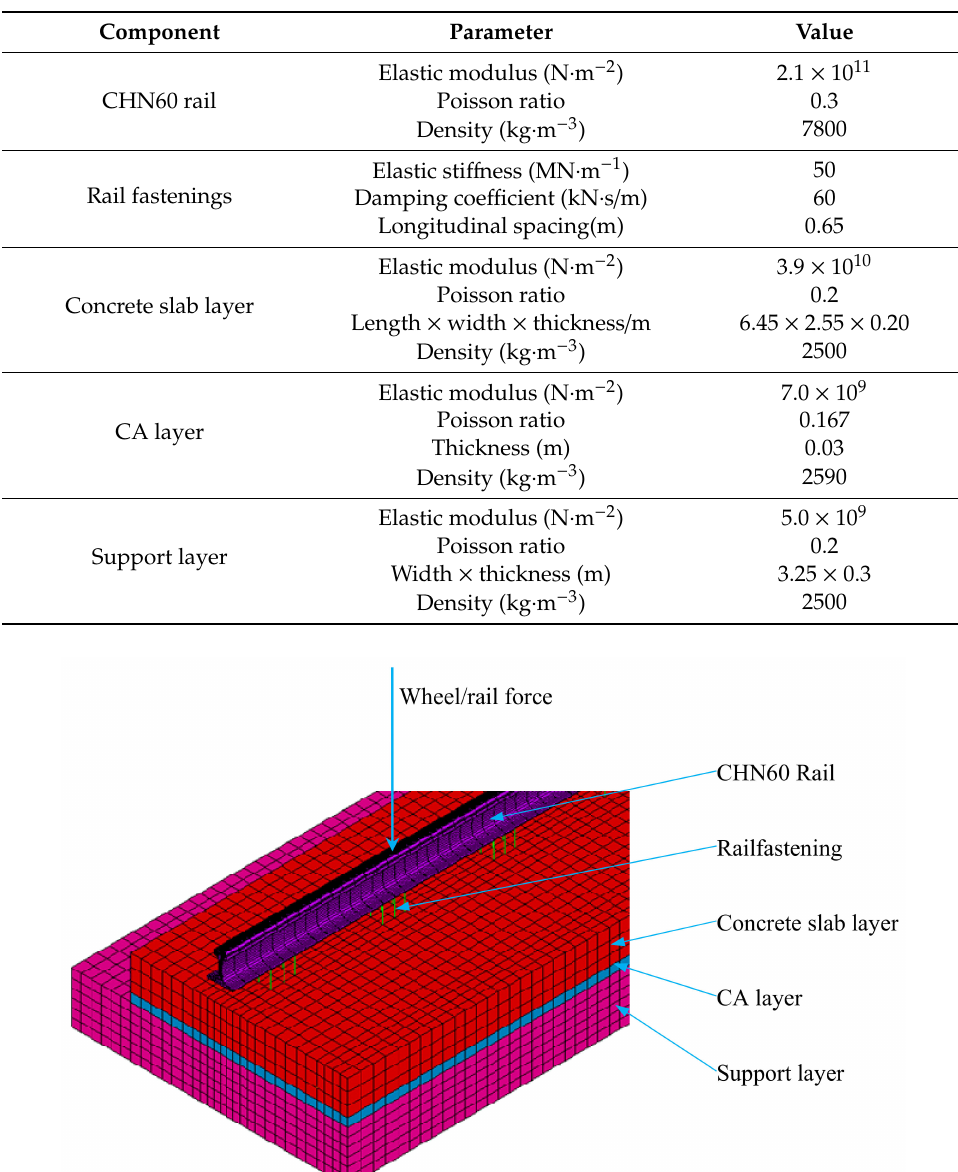
Table 1. Parameters of the slab ballast-less track.